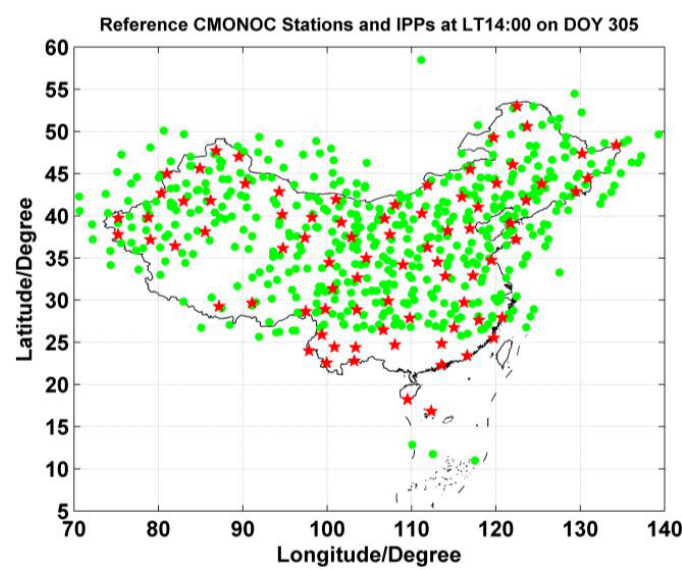
Figure 3. The distribution of the selected reference stations (red pentagram points) and IPPs (green points) at local time 14:00 on DOY 305 of 2014.